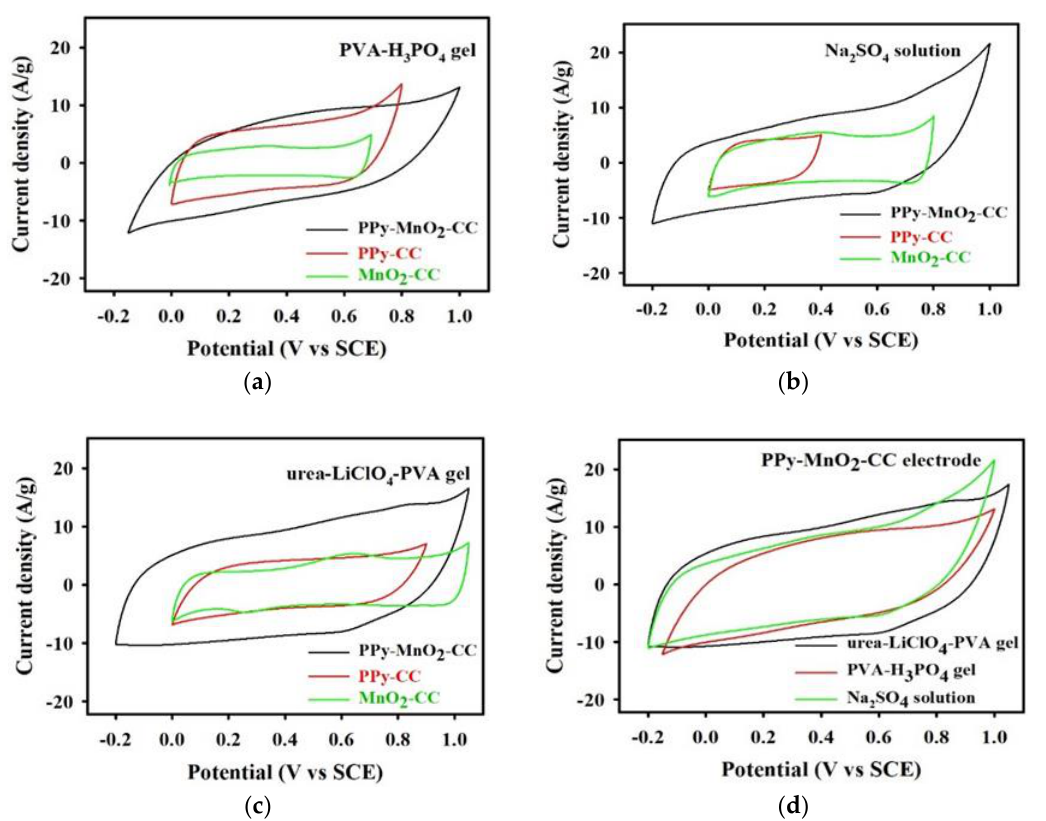
Figure 4. ( a ) CV curves of the PPy-MnO 2 -CC, PPy-CC, and MnO 2 -CC electrodes recorded with 1 M Na 2 SO 4 (10 mV/s). ( b ) CV curve of the PPy-MnO 2 -CC, PPy-CC, and MnO 2 -CC electrodes recorded with PVA-H 3 PO 4 gel electrolyte (10 mV/s). ( c ) CV curve of the PPy-MnO 2 -CC, PPy-CC, and MnO 2 -CC electrodes recorded with urea-LiClO 4 -PVA gel electrolyte (10 mV/s). ( d ) CV curves of the PPy-MnO 2 -CC electrode recorded with different electrolytes (urea-LiClO 4 -PVA gel, PVA/H 3 PO 4 gel, and Na 2 SO 4 solution).